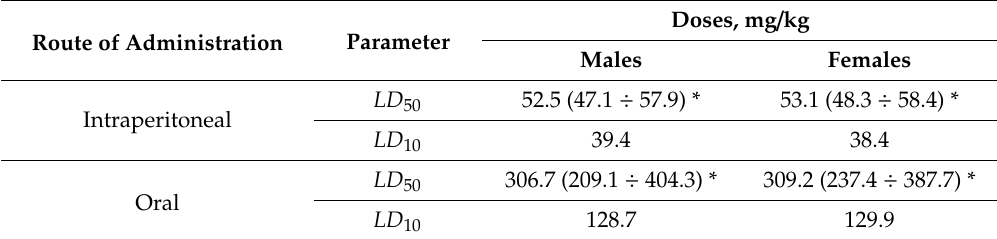
Table 4. Acute toxicity of orally or i.p. administered anthrafuran in mice.